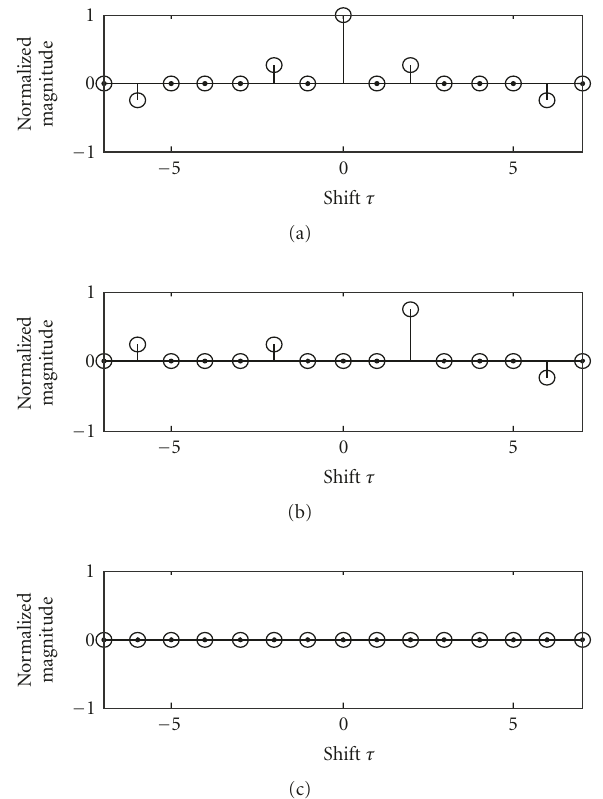
Figure 1: The distribution of aperiodic ACF and CCF values of Z- complementary set Z - CS (8,2,8,2,2). (a) ACF of Z-complementary sequence C 1,1 ; (b) intragroup CCF of C 1,1 and C 1,2 ; (c) intergroup